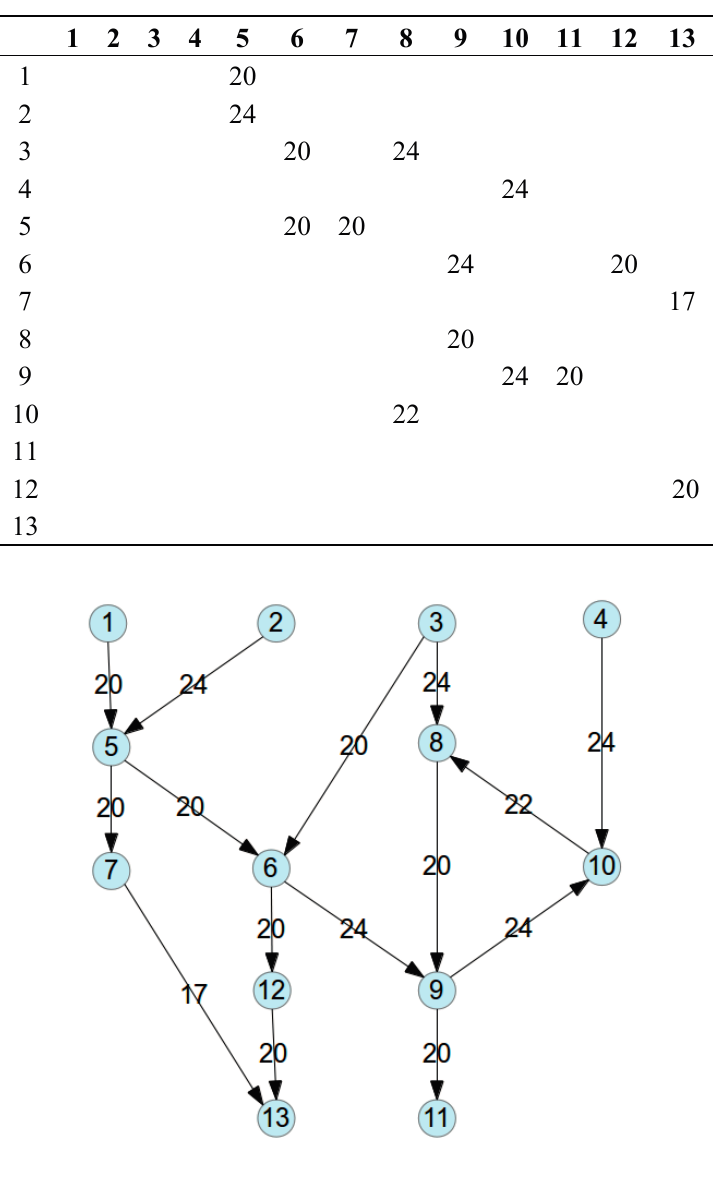
Figure 2. Graph example: